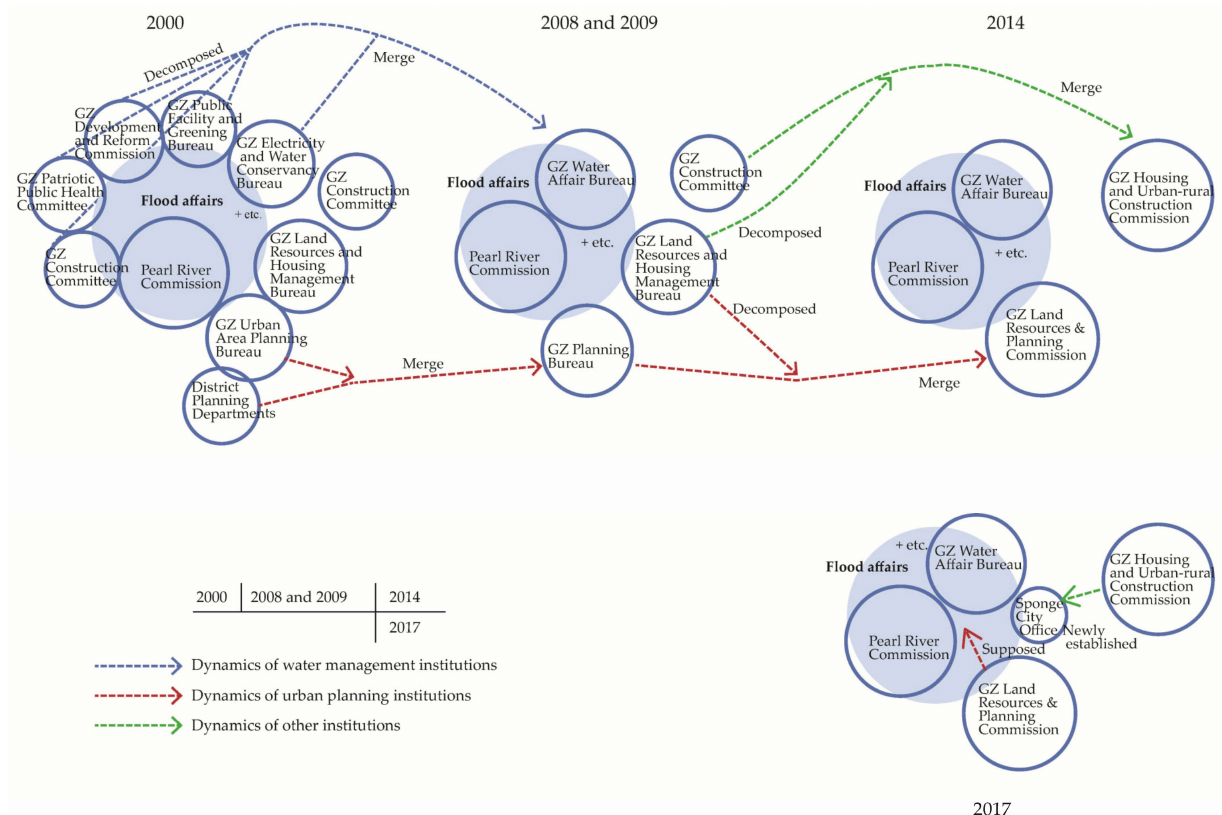
Figure 2. Dynamic organizational structures of Guangzhou